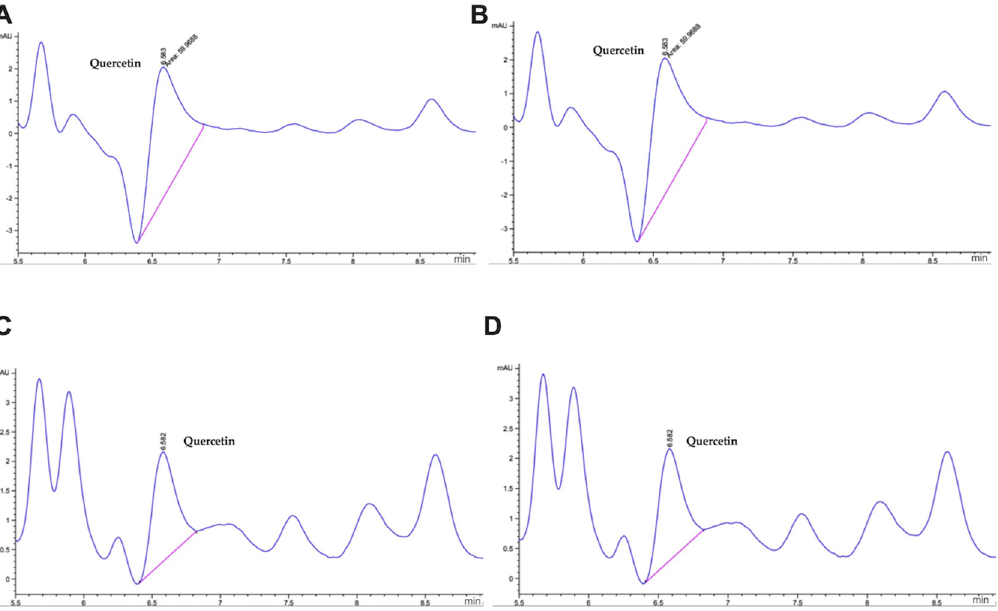
Figure 3. Phytochemical profile by HPLC. Principal compound in different formulations of cookies is quercetin (6.39 min). ( A ) Ch5:A20: 40 g of wheat flour + 5 g of chaya flour + 20 g of amaranth flour; ( B ) Ch10:A15: 40 g of wheat flour + 10 g of chaya flour + 15 g of amaranth flour; ( C ) Ch15:A10: 40 g of wheat flour + 15 g of chaya flour + 10 g of amaranth flour; and ( D ) Ch20:A5: 40 g of wheat flour + 20 g of chaya flour + 5 g of amaranth flour.